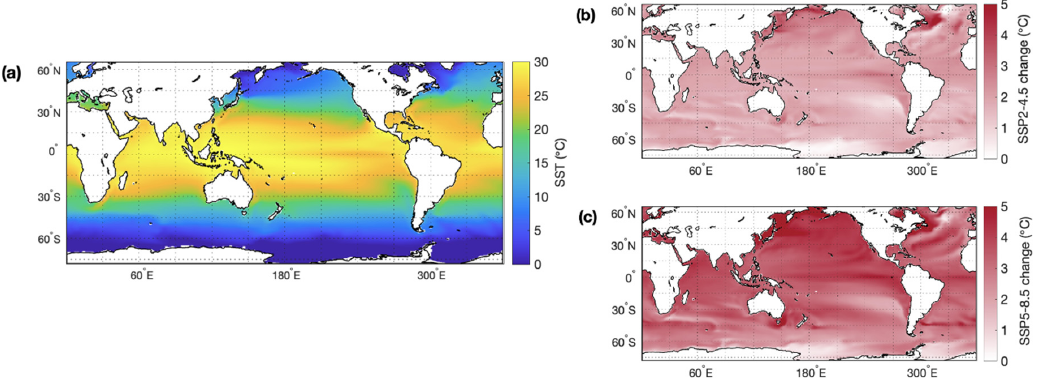
Figure 2. ( a ) Present-day annual mean sea surface temperature (SST) and the change in SST by the end of this century, as simulated by CMIP6 climate models for climate under two emission scenarios: ( b ) SSP2-4.5 and ( c ) SSP5-8.5.